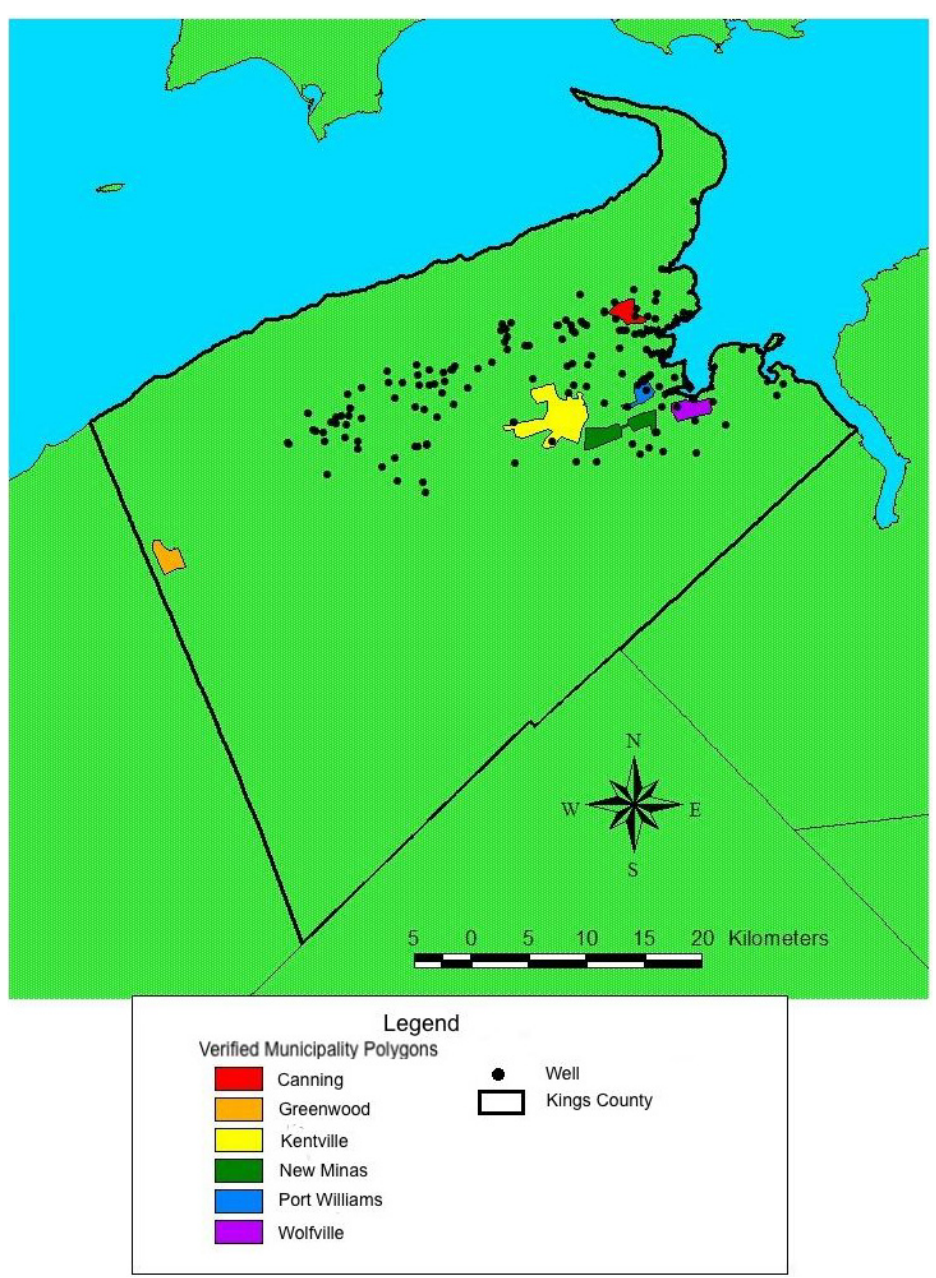
Figure 1. Map of Kings County, Nova Scotia, highlighting the six small town municipal water supplies and the locations of the rural wells from which nitrate concentrations were monitored in 1999 and